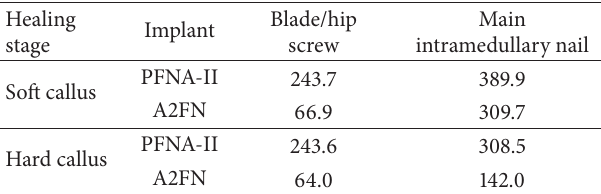
Table 3: Comparison of peak stresses of the femoral head between two implants